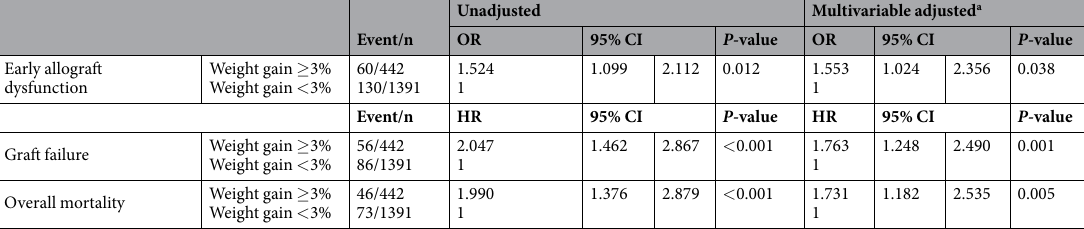
Table 3. Predictive value of postoperative weight gain ≥ 3% for clinical outcomes in living donor liver transplantation recipients. OR, odds ratio; HR, hazard ratio; CI, confidence interval. a Adjusted for all variables in Table 2.